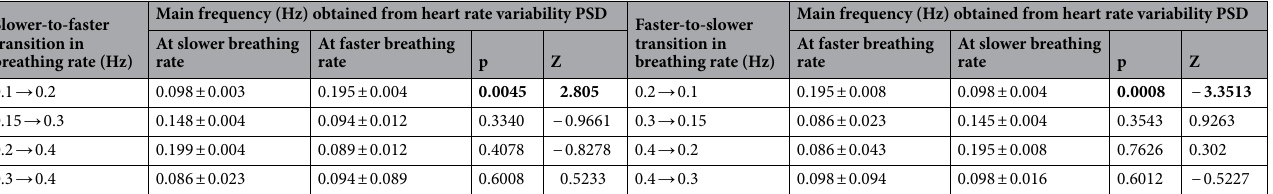
Table 3. Group median + MAD of the main frequency obtained from heart rate variability PSD during the breathing control task. p-values were derived using the paired Wilcoxon test during each session with respect to the resting period. Significant values are in bold.